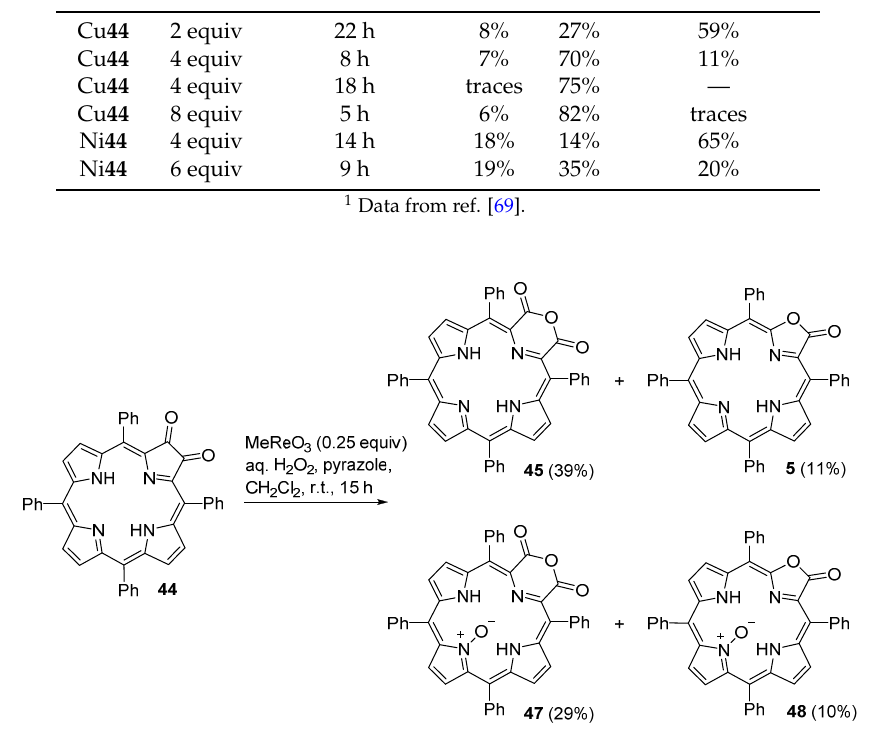
Table 1. Yields of the oxidation of 2,3-dioxochlorins M 44 under different conditions 1 . M44 BSA